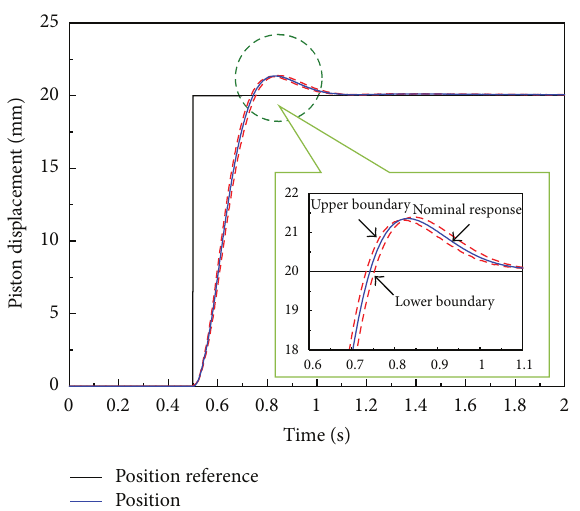
Figure 10: Step response of the optimal antiwindup PID control system in computer simulation based on identified transfer function of EHA